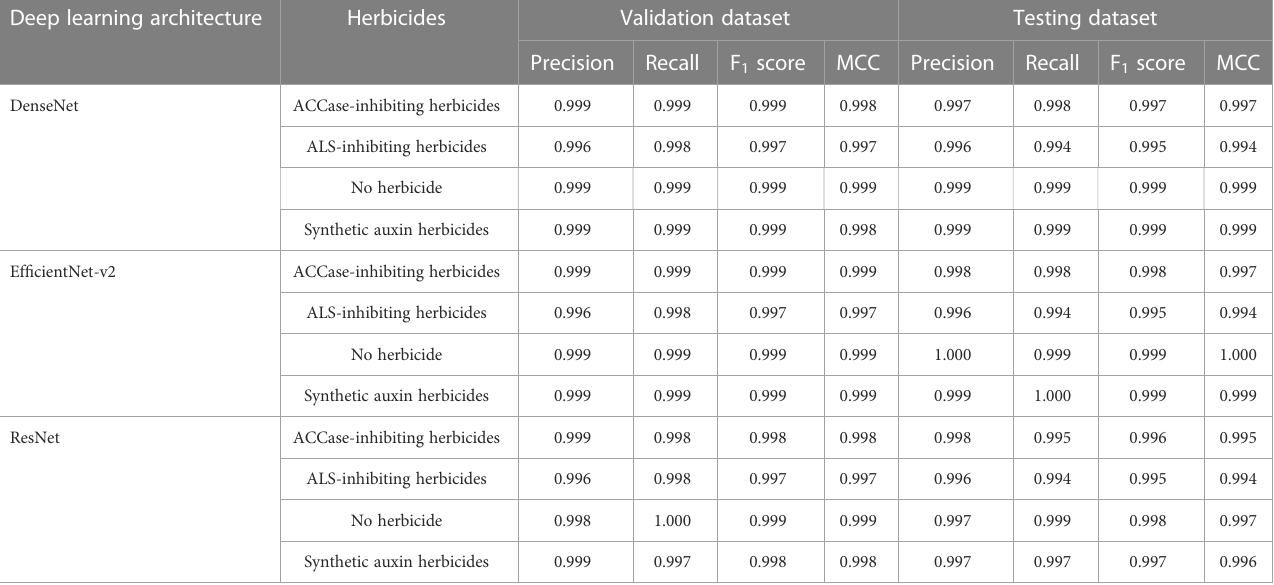
TABLE 4 Training and testing results of various convolutional neural networks for detecting and discriminating the sub-images containing weeds susceptible to herbicides, or bermudagrass without weed infestation (no herbicide). Deep learning architecture